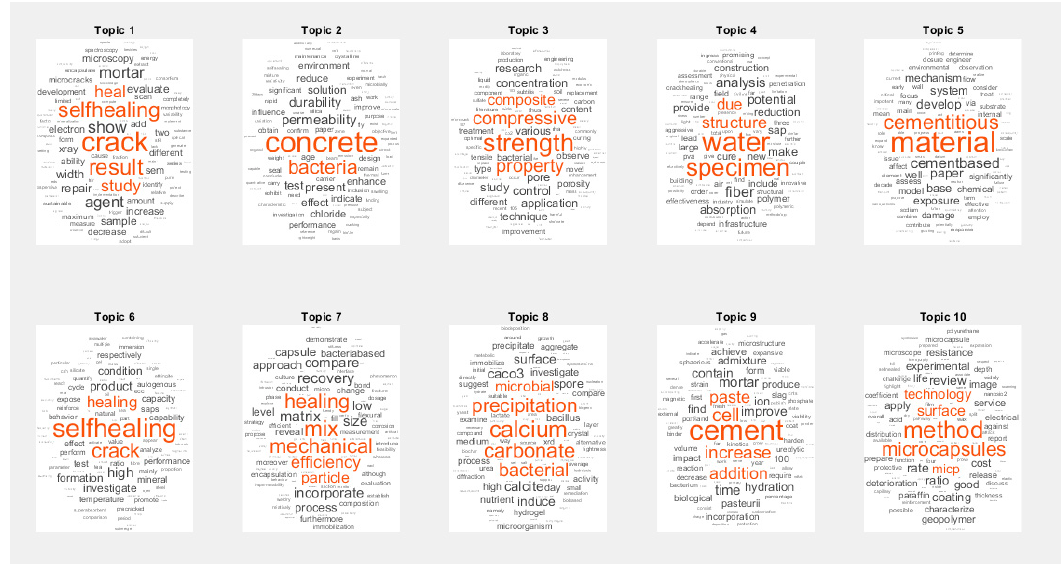
Figure 3. Ten LDA topics generated through MATLAB.